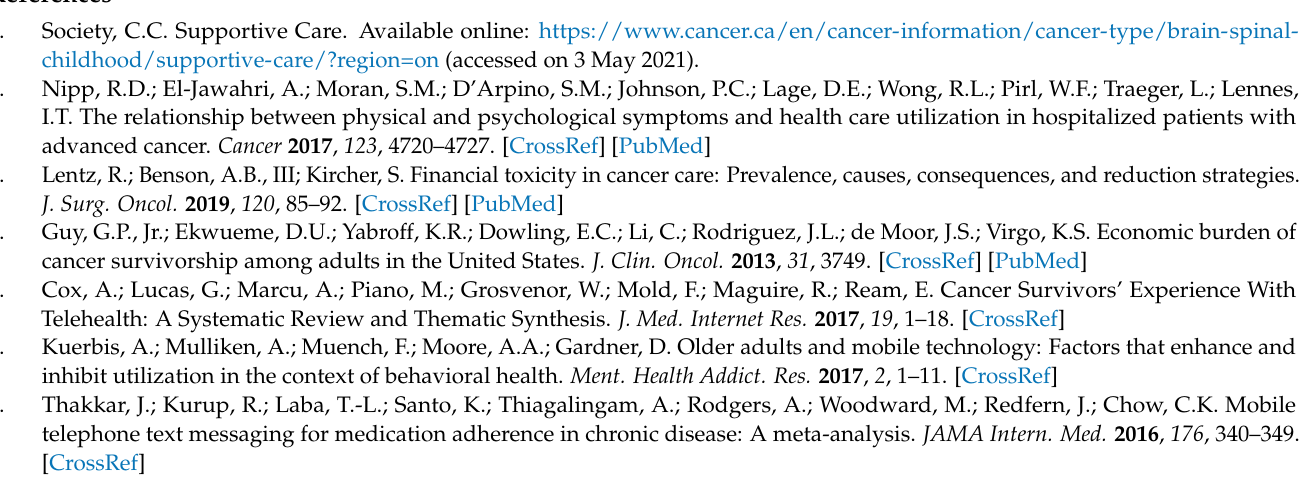
Figure S2: Bias assessment of the non-randomized interventional/observational studies ( n = 9). Table S1: Study inclusion and exclusion criteria. Table S2: Search strategy for included databases. Table S3: Detailed characteristics and outcomes of included studies ( n = 18). Table S4: Cochrane Risk of Bias table for the randomized controlled trials ( n = 9). A score of 0 represents high risk of bias, 1 represents unclear risk of bias, and 2 represents low risk of bias. Table S5: Risk of Bias in Non-randomized Studies-of Interventions (ROBINS-I) table for the non-randomized interventional/observational studies ( n =